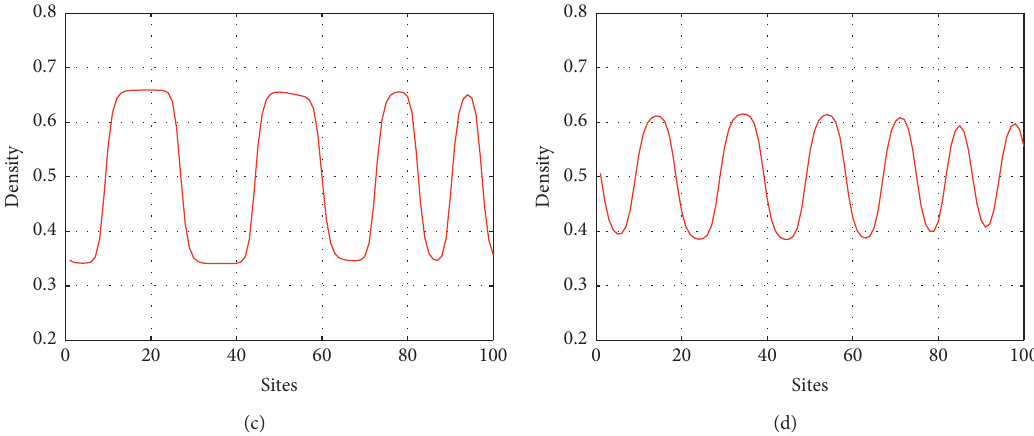
Figure 4: Density profile of the density wave at t � 10300s corresponds to Figure 3. (a) p � 0, (b) p � 0.1, (c) p � 0.2, (d) p � 0.3.